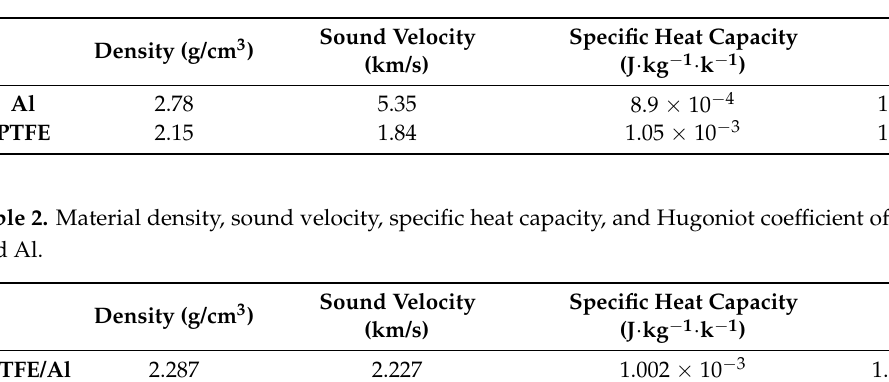
Table 1. Material density, sound velocity, specific heat capacity, and Hugoniot coefficient of PTFE and Al.